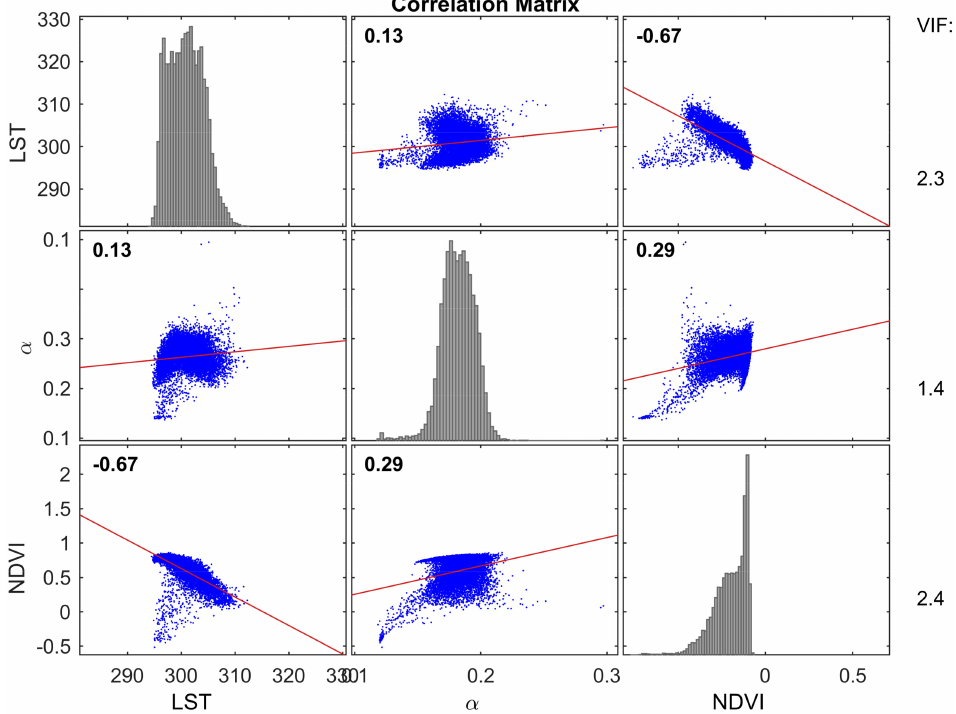
Figure A2. Correlation matrix and VIF analysis for the group Landsat Data at a resolution of 200